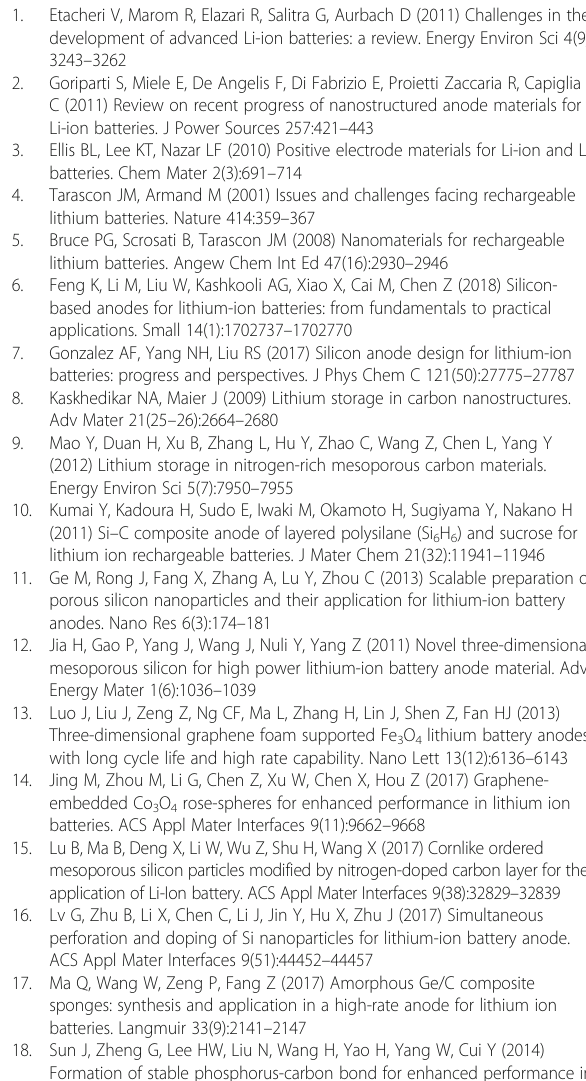
Additional file 1: Figure S1. The reaction process of RPNPs via the solution synthesis. Figure S2. Optical images of RPNPs and commercial RP powders. Figure S3. I-V curves of RPNPs. Figure S4. SEM images of commercial RP. (DOCX 631